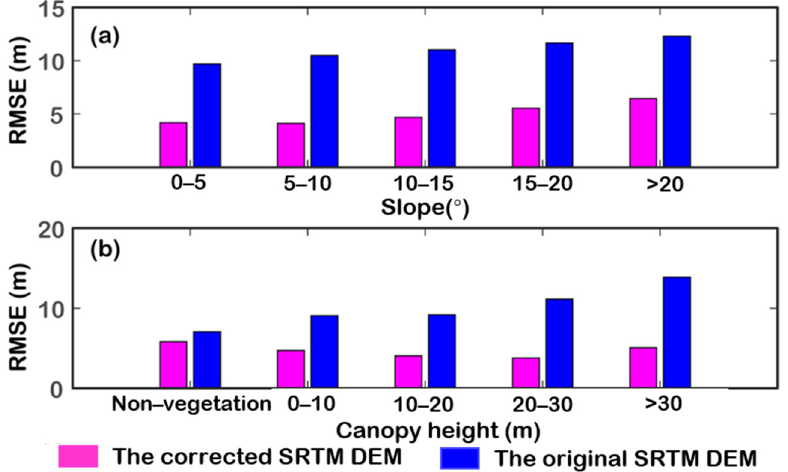
Figure 6. The relationship between the RMSE value of the corrected/original SRTM DEM and ( a ) slope and ( b ) canopy height.